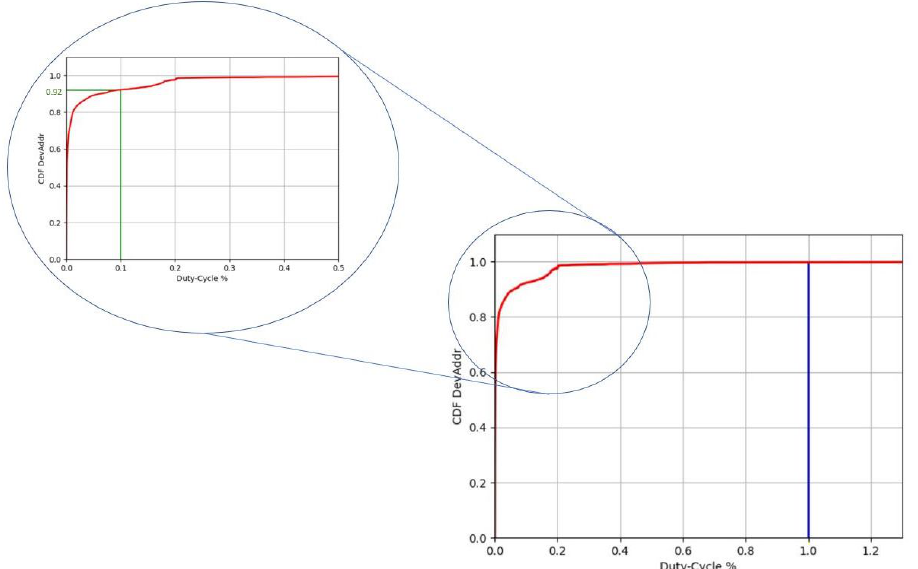
Figure 14. Plot of CDF of end-devices in the function of the percentage of the duty-cycle with zoom on duty-cycle percentage range [0, 0.5]. In the complete graph, the blue line represents the duty- cycle constraint of 1% while in the zoom the green line represents the duty-cycle of 0.1% and the correspondent CDF of